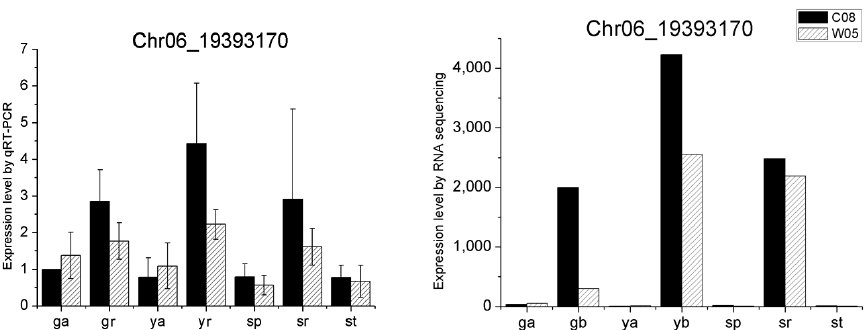
Figure 1. Validation of differential expressions of sRNAs. The differential expressions of miRNAs and phasiRNAs identified by sRNA sequencing ( right ) were validated by qRT-PCR ( left ). Y -axis showed the normalized reads of sRNA in 14 samples ( right ) and relative expression levels ( left ). Error bar shows the standard deviation (SD) of the three biological replicates used in qRT-PCR.